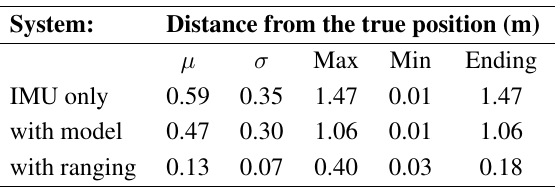
Table 1. Tracking